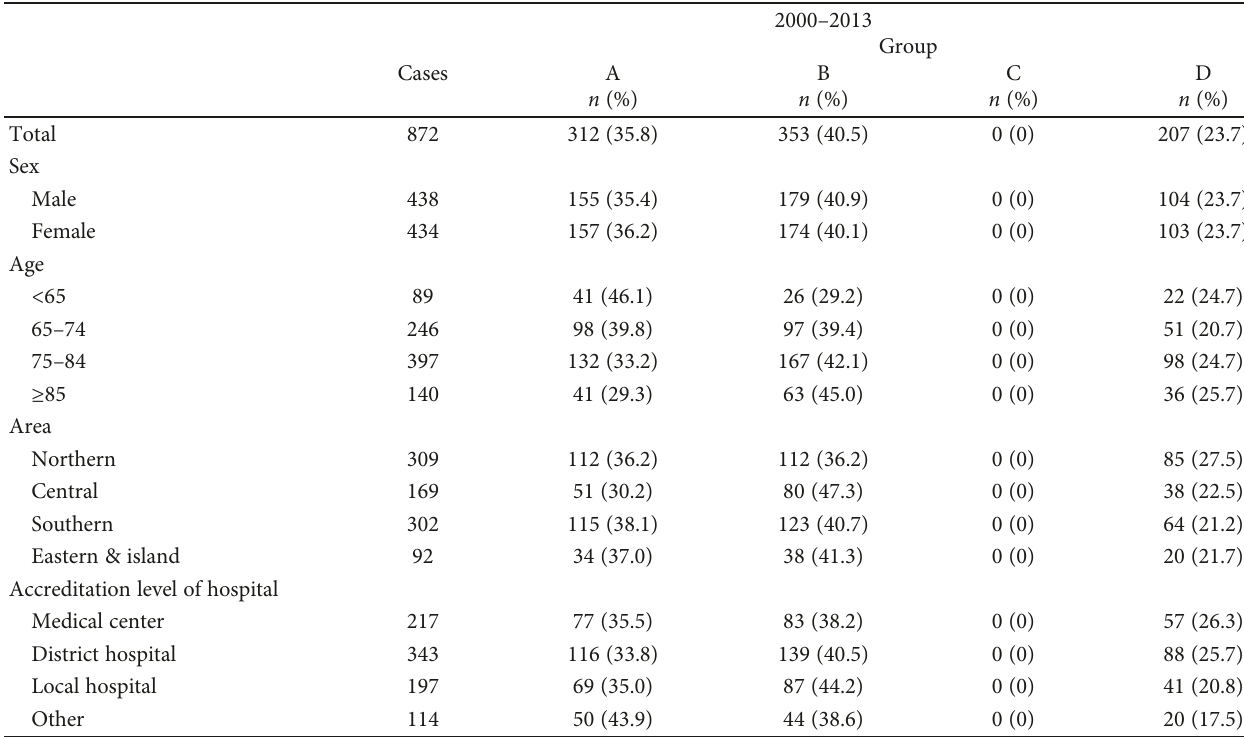
Table 3: Classi fi ed DLB